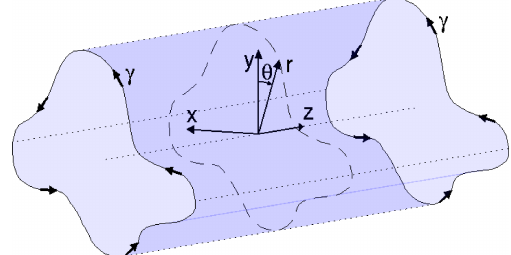
Figure A1. Sketch of an infinitely long extruded surface of tangen- tial vortex density γ with an arbitrary cross-section.